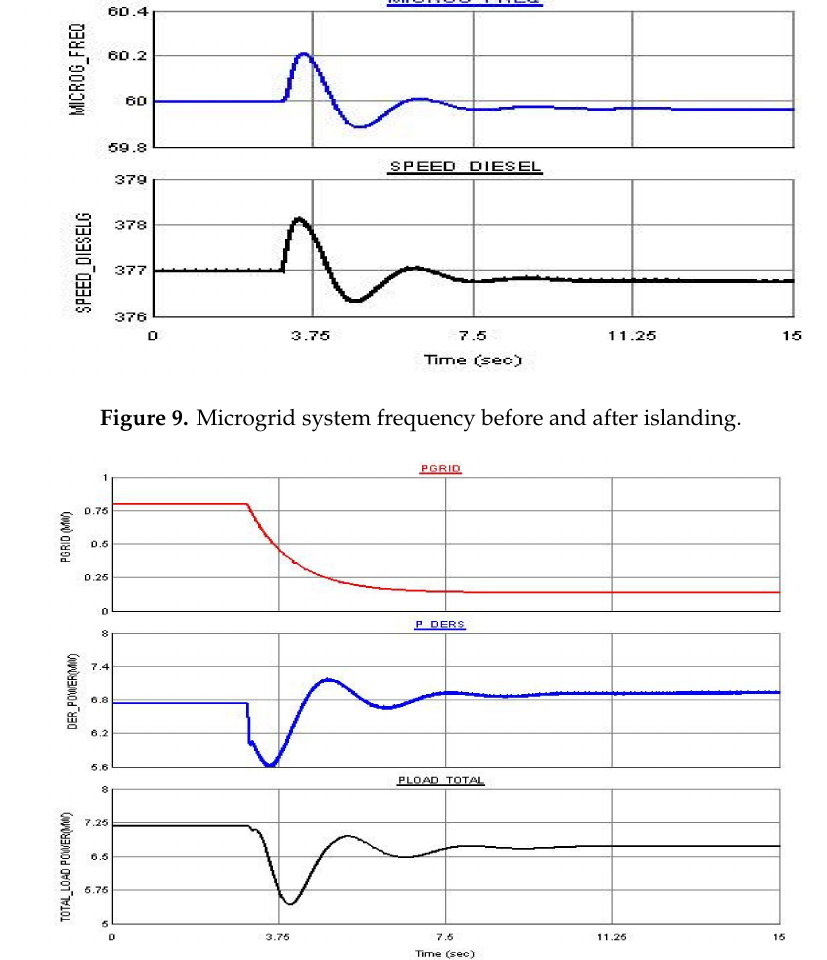
Figure 10. Grid, DERs and Load active powers from grid connected to island